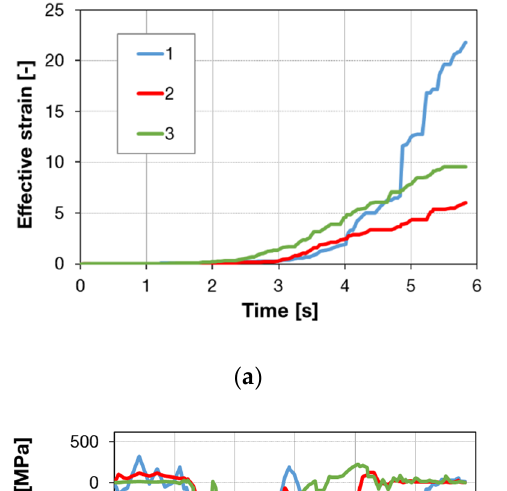
( b ) Figure 9. Microstructure of as-received titanium Grade 4: ( a ) longitudinal cross-section, ( b ) transverse cross-section—optical light microscopy. ( a )